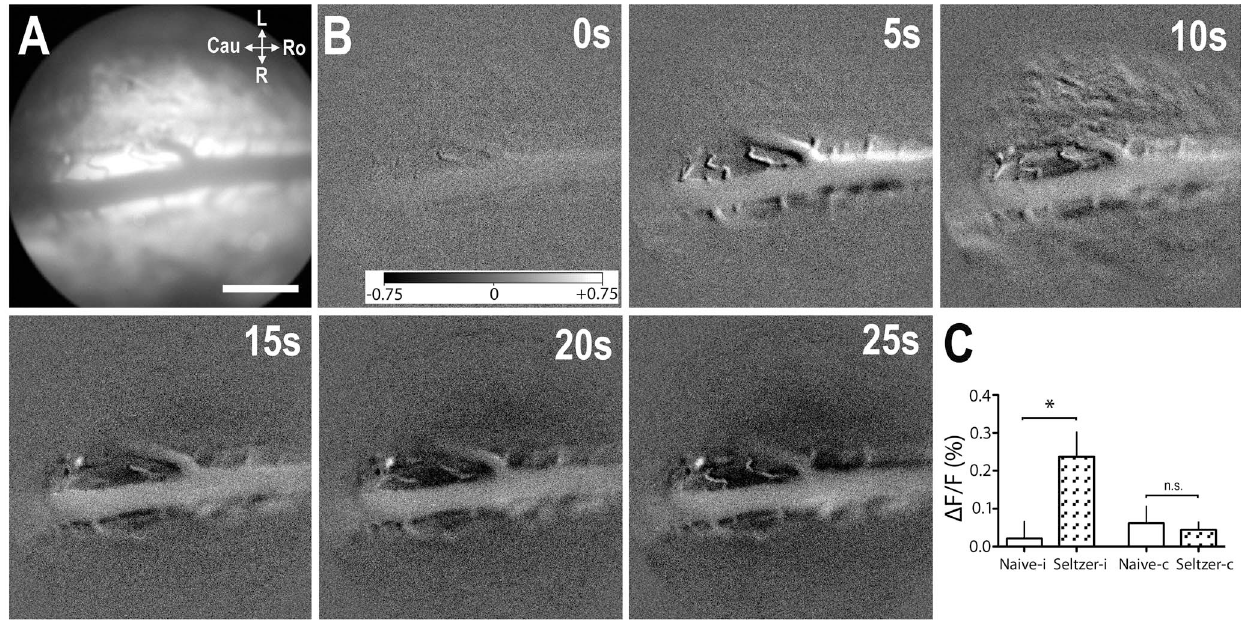
Figure 4. Intensity of the AFI signal, following innocuous palpation in naı¨ve rats and rats with partial ligation of the proximal sciatic nerve (Seltzer model). (A) Image of background fluorescence of the dorsal surface of the spinal cord at T13. (B) Subtracted D F/F images at various time points after start of 10 seconds, 1 Hz innocuous palpation of the plantar surface of the left hindpaw. (C) Mean D F/F of the light phase in 20 6 20 pixel square selections on the ipsi-(i) and contralateral (c) side at the L4-6 spinal level, in naı¨ve rats from our previous experiments [3] and in rats with partial ligation of the proximal sciatic nerve (Seltzer model). Scale bar, 1 mm. Gray scale bar ranging from 2 0.75% (black) to + 0.75% (white) of the 16- bit range. Error bars indicate SEM; * p , 0.05; unpaired t -test; n =5 naı¨ve rats, n =5 neuropathic rats.